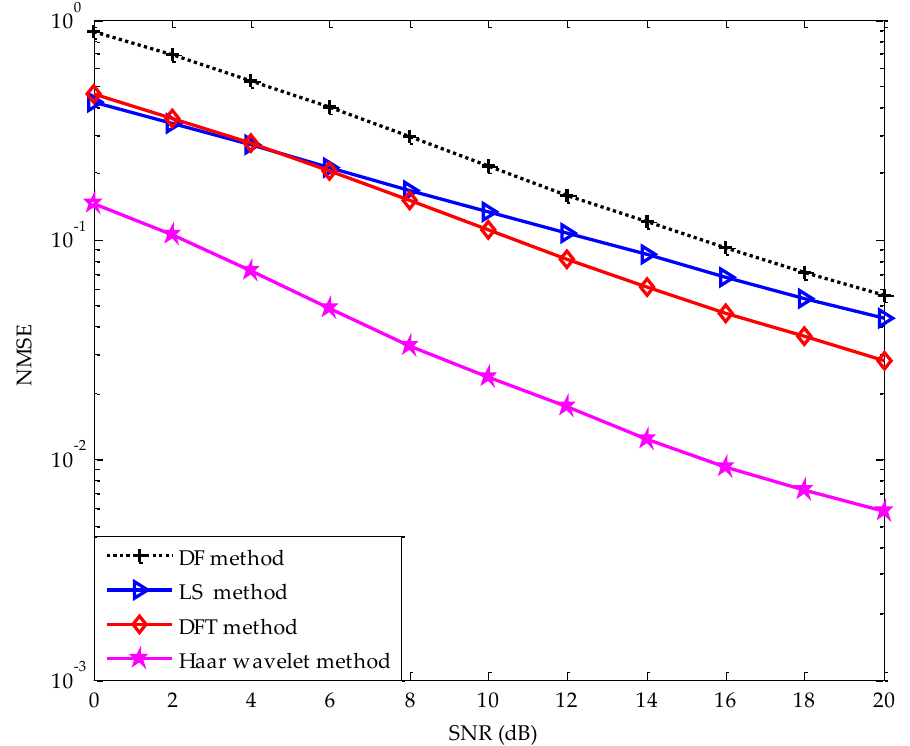
Figure 9. NMSE performance of QPSK modulated CP-OFDM and wavelet-OFDM systems under CDT6 channel.